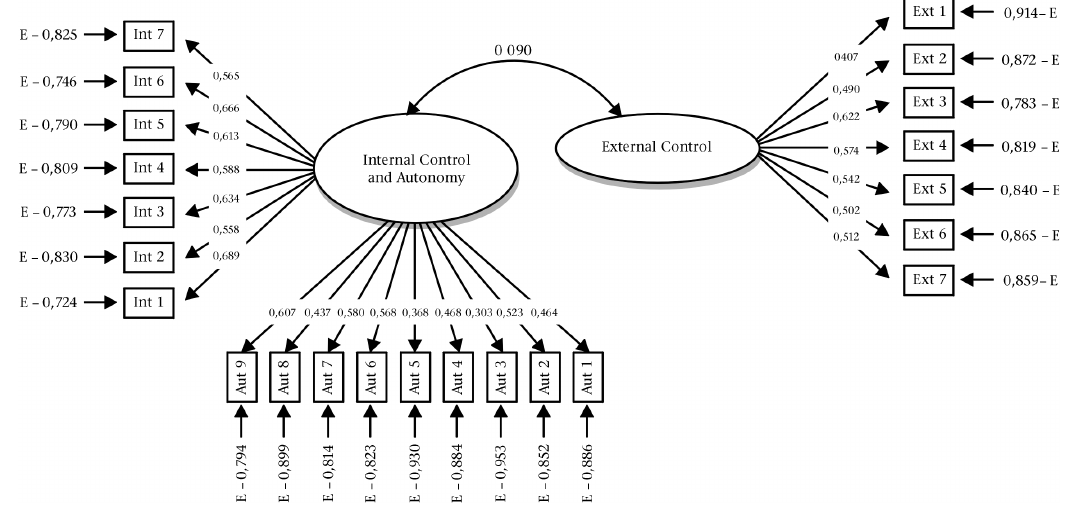
Figure 4: Standardised estimated parameters of the two-factor LCI model for the second